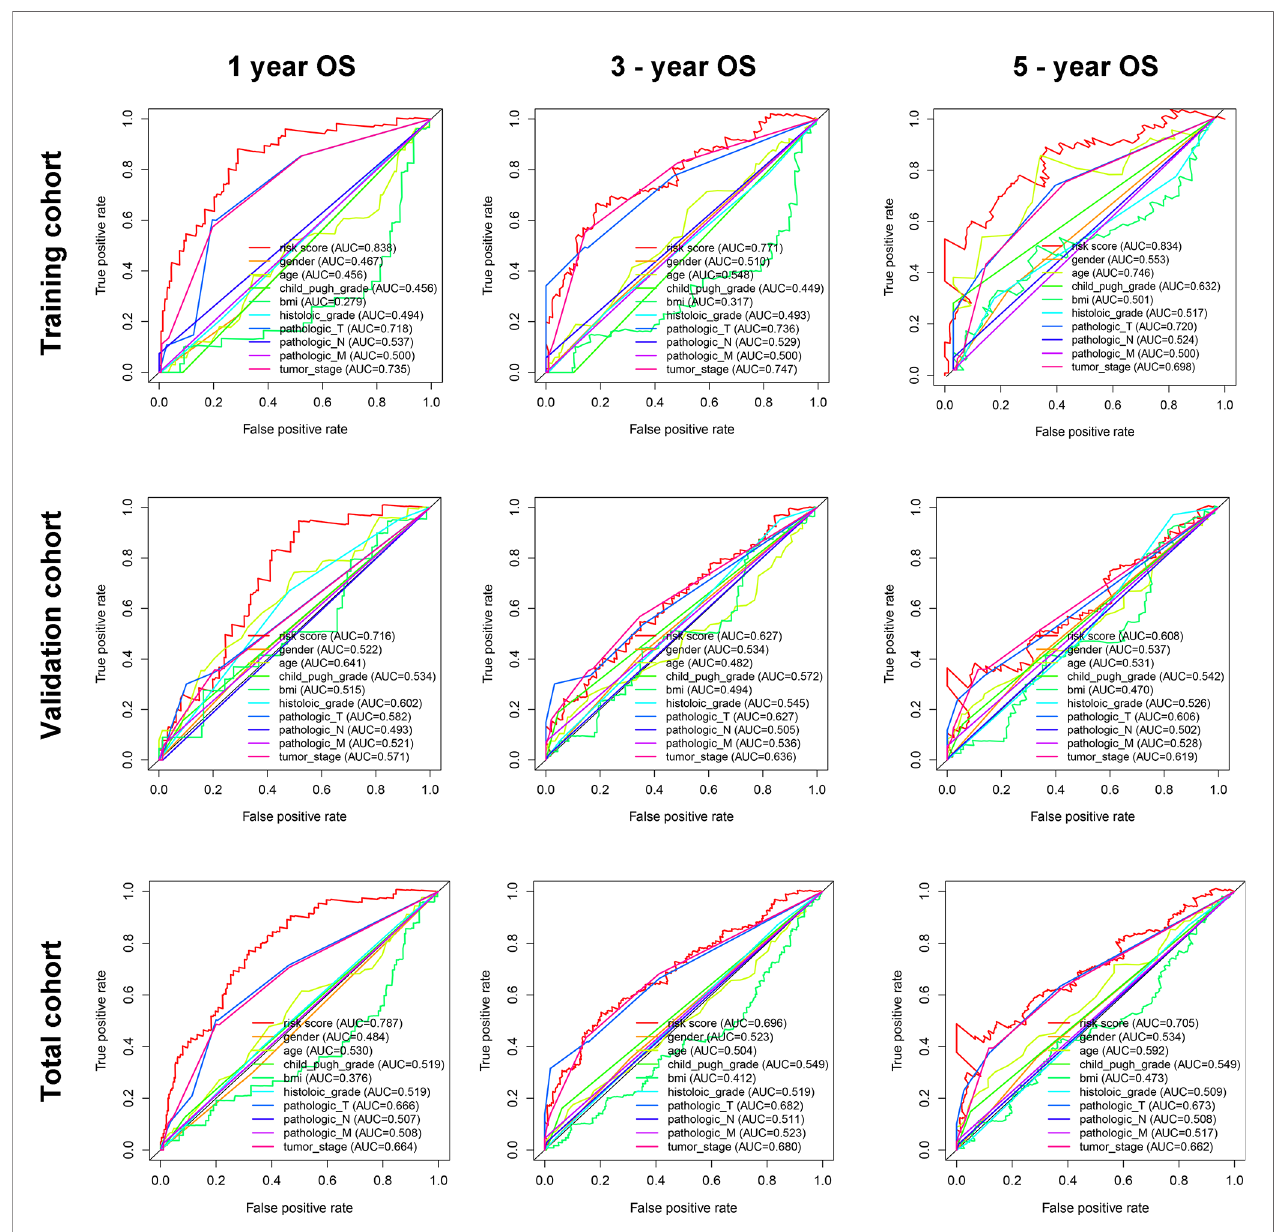
FIGURE 5 | The time-dependent ROC for 1-, 3-, and 5-year overall survival predictions for the classi fi er in comparison with clinical features in the training, validation, and total cohorts of